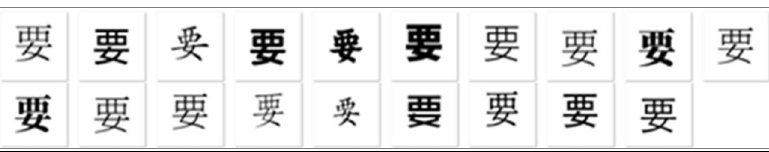
Figure 12. Example characters in 19 different styles.